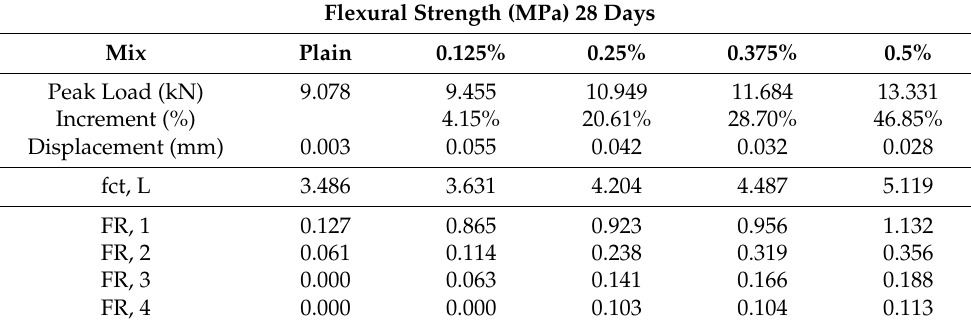
Table 5. The result of residual flexural